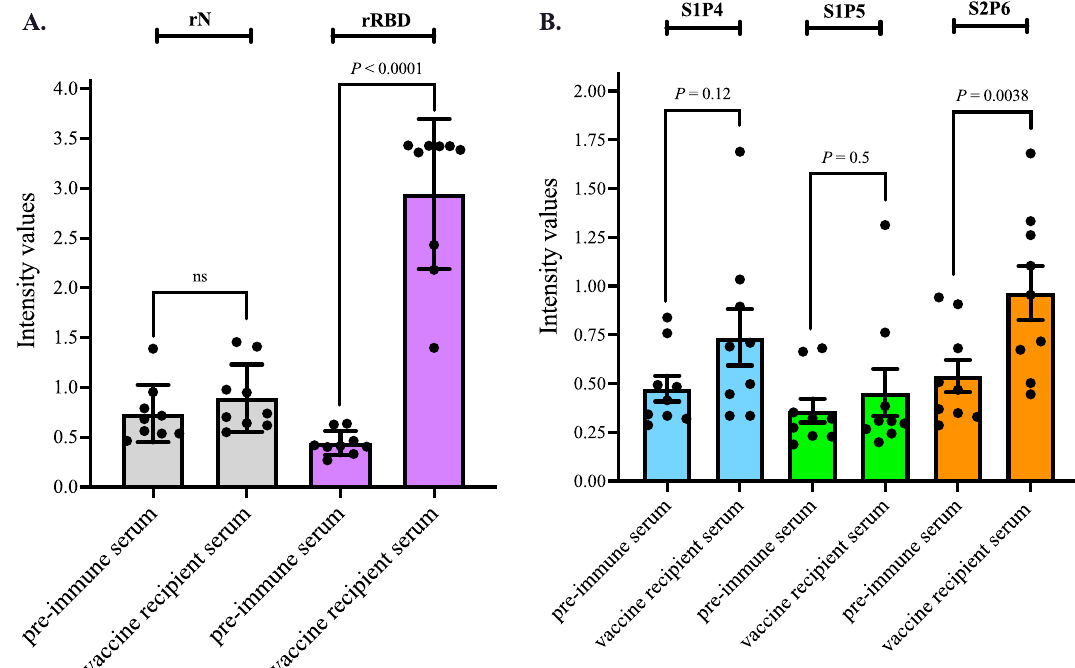
Figure 5. Immune reactivity of comirnaty vaccine recipient sera against the synthetic S1P4 and S2P6 peptides. Serum samples from comirnaty vaccine recipients (n = 9) (Table S4) were collected few weeks after the receipt of the second vaccine dose. The pre-immune serum of each individual was collected prior vaccination. In ( A ), serum samples at dilution 1:100 have been tested for SARS-CoV-2 N and S antibodies by indirect ELISA using soluble rN and rRBD proteins for antigen-based antibody capture. The intensity values of serum samples were measured at O.D. 450 nm. Paired t tests were performed between pre-immune serum and vaccine recipient serum (ns: non-statistically significant, p > 0.05). In ( B ), the serum samples were assayed on the synthetic S2P4 and S2P6 peptides (200 ng.ml −1 ) through peptide-based ELISA at serum dilution 1:50. The synthetic S1P5 peptide served as negative control serum. The intensity values of vaccine serum samples were measured at O.D. 450 nm. Paired t tests were performed between pre-immune serum and vaccine recipient